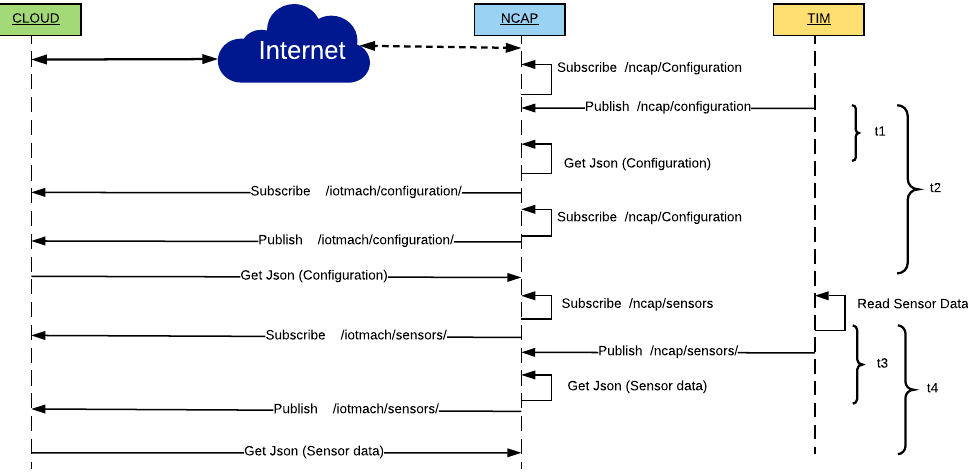
Figure 33. Sequence diagram that illustrates how the latencies for the Ethernet TIM were obtained.